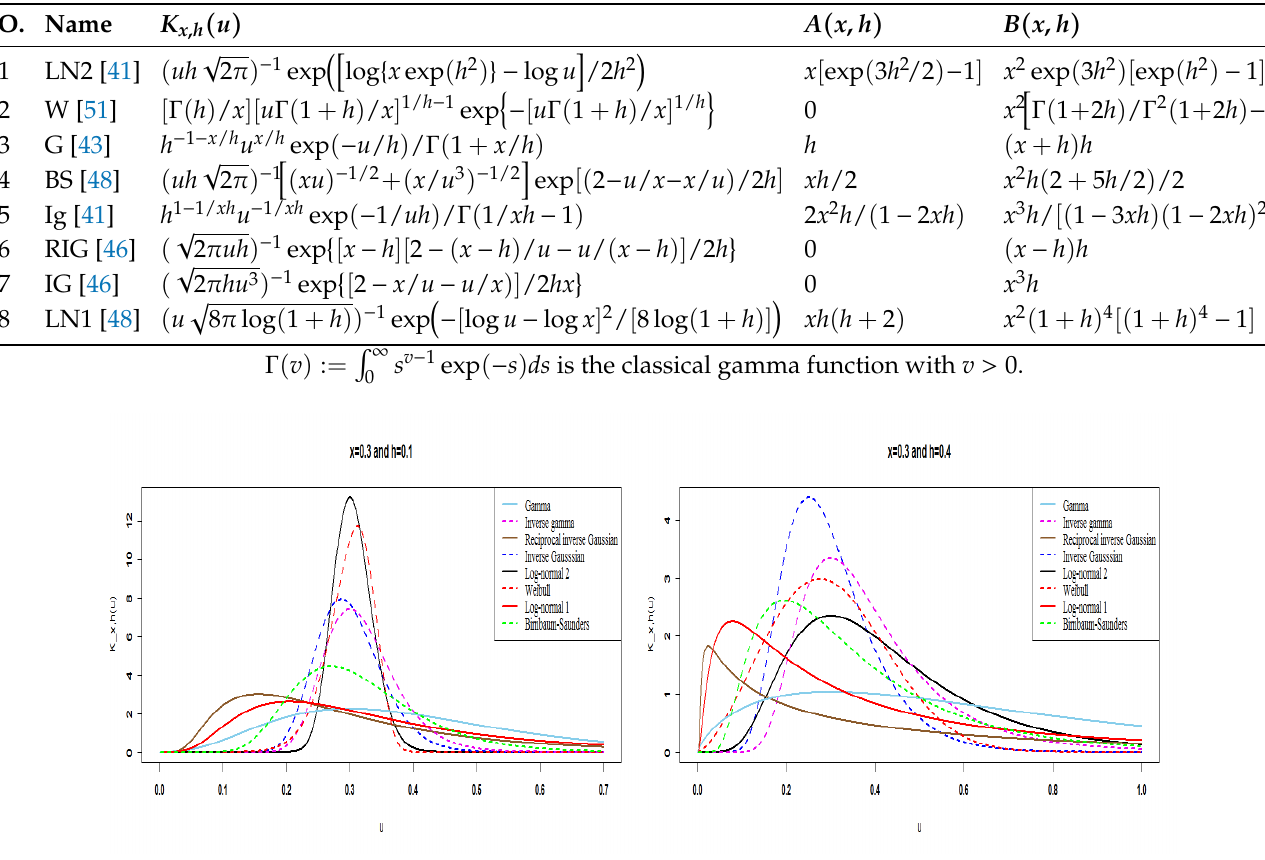
Figure 1. Comparative graphics of the eight univariate semicontinuous associated kernels of Table 1 on the edge ( x = 0.3) with h = 0.1 and h = 0.4.